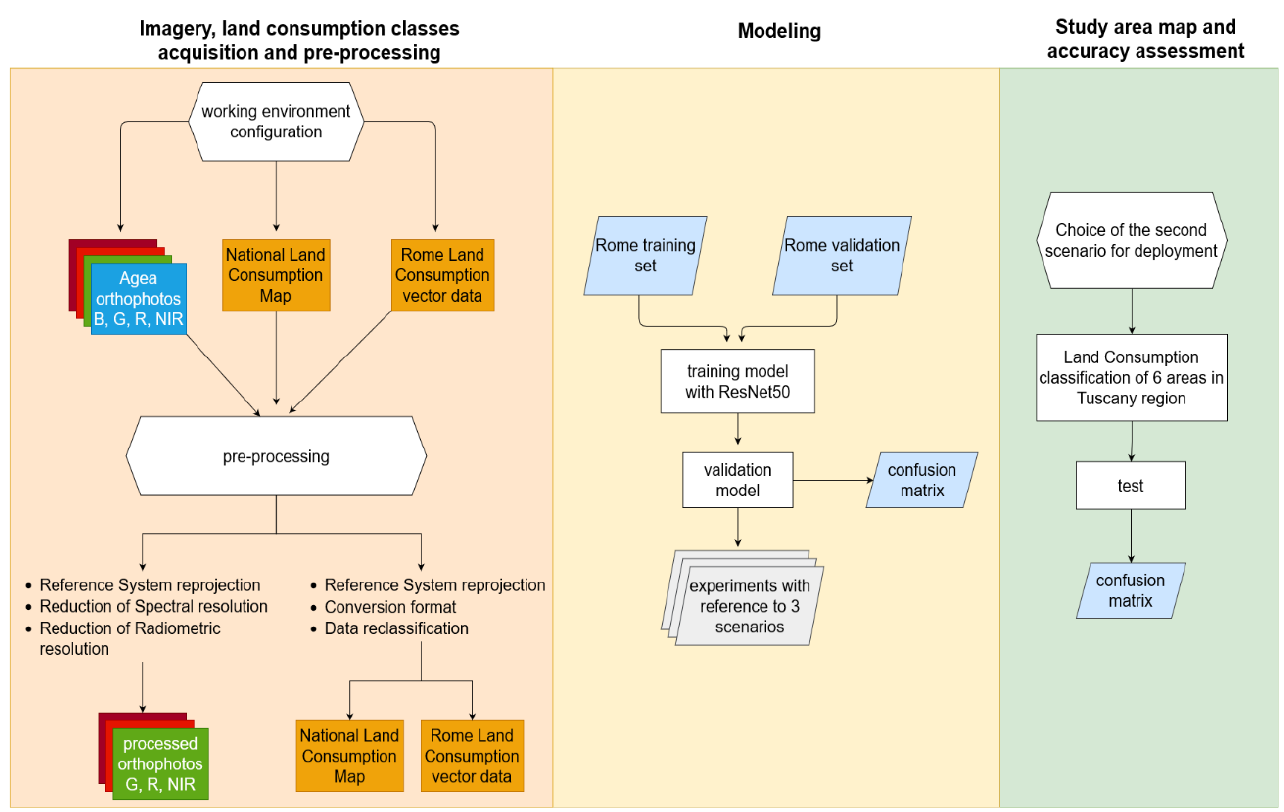
Figure 3. Study workflow.